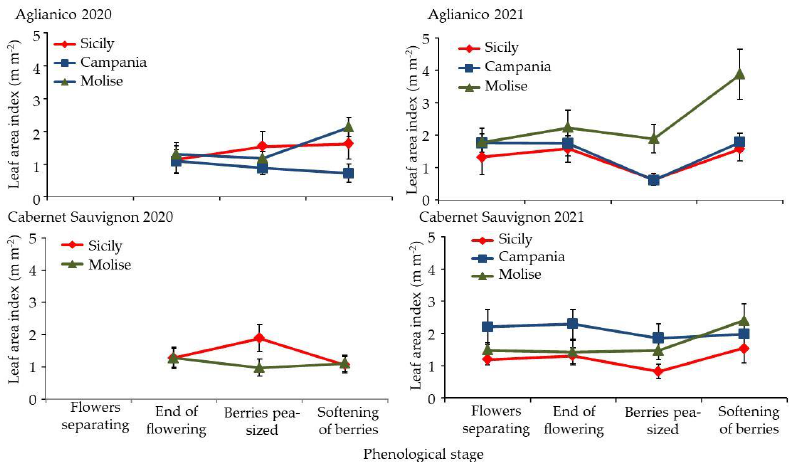
Figure 6. Leaf area indexes registered in each of two cultivars, Aglianico (AGL) and Cabernet Sauvignon (CAB), grown at three different sites, Molise (MOL), Campania (CAM), and Sicily (SIC). Measurements were made the phenological stages BBCH57 (only second year) flowers separating, BBCH69 end of flowering, BBCH75 berries pea-sized, and BBCH85 softening of berries, during the second year. Mean values for each parameter indicated by different letters are significantly different ( p ≤ 0.001) (bars indicate one standard deviation), based on Tukey’s HSD test within sites and years.